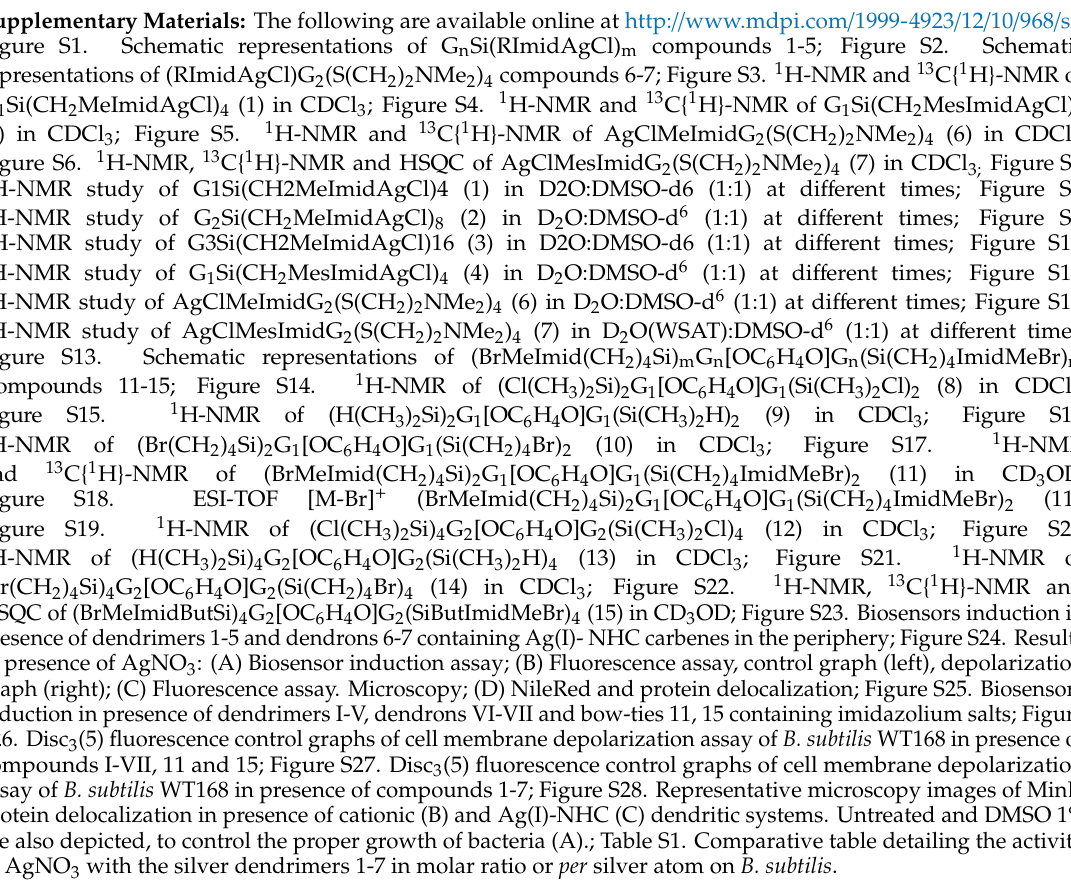
Figure S1. Schematic representations of G n Si(RImidAgCl) m compounds 1-5; Figure S2. Schematic representations of (RImidAgCl)G 2 (S(CH 2 ) 2 NMe 2 ) 4 compounds 6-7; Figure S3. 1 H-NMR and 13 C{ 1 H}-NMR of G 1 Si(CH 2 MeImidAgCl) 4 (1) in CDCl 3 ; Figure S4. 1 H-NMR and 13 C{ 1 H}-NMR of G 1 Si(CH 2 MesImidAgCl) 4 (4) in CDCl 3 ; Figure S5. 1 H-NMR and 13 C{ 1 H}-NMR of AgClMeImidG 2 (S(CH 2 ) 2 NMe 2 ) 4 (6) in CDCl 3 ; Figure S6. 1 H-NMR, 13 C{ 1 H}-NMR and HSQC of AgClMesImidG 2 (S(CH 2 ) 2 NMe 2 ) 4 (7) in CDCl 3; Figure S7. 1H-NMR study of G1Si(CH2MeImidAgCl)4 (1) in D2O:DMSO-d6 (1:1) at di ff erent times; Figure S8. 1 H-NMR study of G 6 (1:1) at di ff erent times; Figure S9. 2 Si(CH 2 MeImidAgCl) 8 (2) in D 2 O:DMSO-d 1H-NMR study of G3Si(CH2MeImidAgCl)16 (3) in D2O:DMSO-d6 (1:1) at di ff erent times; Figure S10. 1 H-NMR study of G 6 (1:1) at di ff erent times; Figure S11. 1 Si(CH 2 MesImidAgCl) 4 (4) in D 2 O:DMSO-d 1 H-NMR study of AgClMeImidG 6 (1:1) at di ff erent times; Figure S12. 2 (S(CH 2 ) 2 NMe 2 ) 4 (6) in D 2 O:DMSO-d 1 H-NMR study of AgClMesImidG 6 (1:1) at di ff erent times; 2 (S(CH 2 ) 2 NMe 2 ) 4 (7) in D 2 O(WSAT):DMSO-d Figure S13. Schematic representations of (BrMeImid(CH 2 ) 4 Si) m G n [OC 6 H 4 O]G n (Si(CH 2 ) 4 ImidMeBr) m 1 H-NMR of (Cl(CH 3 ) 2 Si) 2 G 1 [OC 6 H 4 O]G 1 (Si(CH 3 ) 2 Cl) 2 (8) in CDCl 3 ; Figure S15. 1 H-NMR of (H(CH 3 ) 2 Si) 2 G 1 [OC 6 H 4 O]G 1 (Si(CH 3 ) 2 H) 2 (9) in CDCl 3 ; Figure S16. 1 H-NMR of (Br(CH 1 H-NMR 2 ) 4 Si) 2 G 1 [OC 6 H 4 O]G 1 (Si(CH 2 ) 4 Br) 2 (10) in CDCl 3 ; Figure S17. in CD 3 OD; Figure Figure S19. Figure S20. 1 H-NMR of (H(CH 1 H-NMR of 3 ) 2 Si) 4 G 2 [OC 6 H 4 O]G 2 (Si(CH 3 ) 2 H) 4 (13) in CDCl 3 ; Figure S21. (Br(CH 2 ) 4 Si) 4 G 2 [OC 6 H 4 O]G 2 (Si(CH 2 ) 4 Br) 4 (14) in CDCl 3 ; Figure S22. 1 H-NMR, 13 C{ 1 H}-NMR and HSQC of (BrMeImidButSi) 4 G 2 [OC 6 H 4 O]G 2 (SiButImidMeBr) 4 (15) in CD 3 OD; Figure S23. Biosensors induction in presence of dendrimers 1-5 and dendrons 6-7 containing Ag(I)- NHC carbenes in the periphery; Figure S24. Results in presence of AgNO 3 : (A) Biosensor induction assay; (B) Fluorescence assay, control graph (left), depolarization graph (right); (C) Fluorescence assay. Microscopy; (D) NileRed and protein delocalization; Figure S25. Biosensors S26. Disc 3 (5) fluorescence control graphs of cell membrane depolarization assay of B. subtilis WT168 in presence